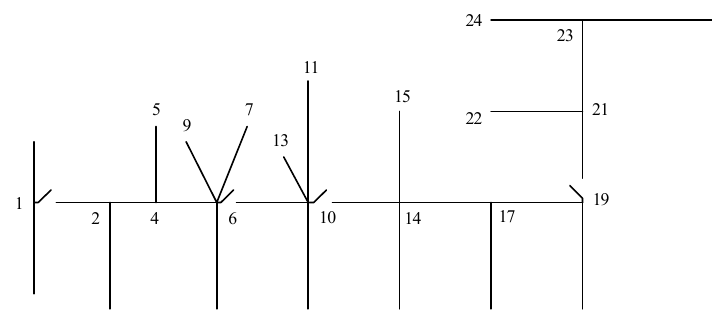
Figure 9. Example 1: optimal switch-distribution map (no contact, three switches).